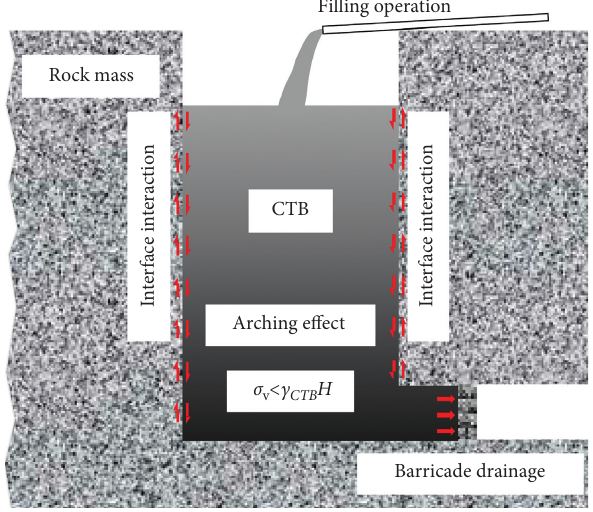
Figure 1: Schematic diagram of factors affecting the internal stress in stope ( σ v : total vertical stress, c CPB : unit weight of CPB, and H : filling